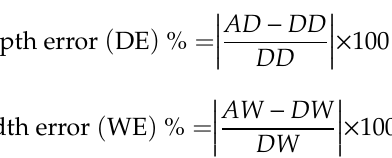
Table 6. Results of dimensional accuracy of the machined pockets.